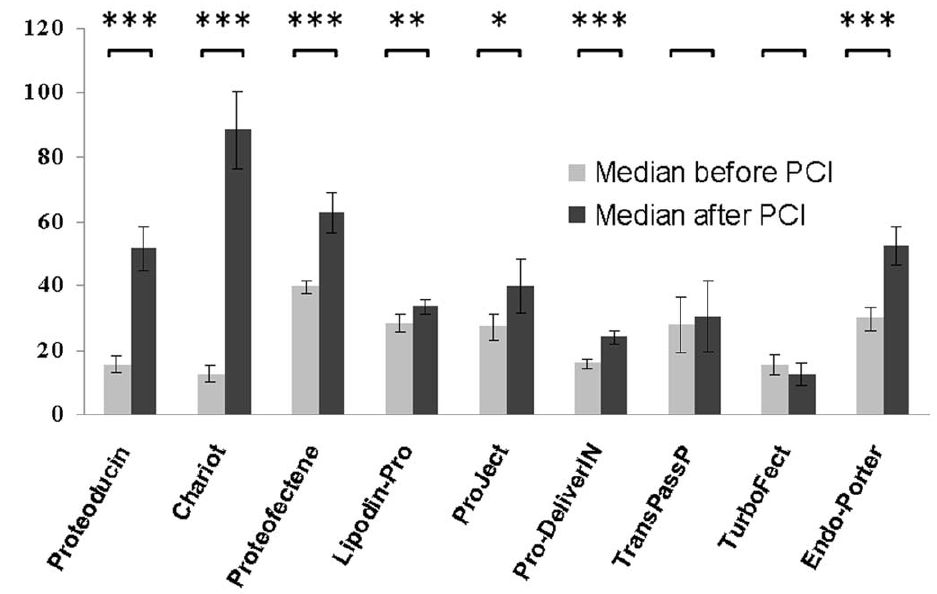
Figure 5. Change of signal distribution after PCI treatment. The median of the pixel gray values was calculated in fluorescence images of Atto488-BSA transduced sarcoma cells using different transduction reagents. Single cells were defined as region of interest in the ImageJ software and the median of the gray values was compared between cells before and after PCI treatment as described in Methods. The means of the medians of the gray values before and after PCI treatment are given. Error bars represent the 95% confidence intervals (n=10). CPP-based transduction reagents (Proteoducin and Chariot) show high signal distribution changes. Reagents based on lipids (Proteofectene, Lipodin-Pro, ProJect and Pro- DeliverIN) also show changes but with partially lower significance. Reagents described as non-lipid or cationic polymers (TransPassP and TurboFect) did not lead to a signal spreading as a reason of a PCI treatment. The cytosolic signals produced by transduction with the endosomolytic reagent Endo-Porter was increased significantly by further disruption of endo- and lysosomes by PCI treatment.